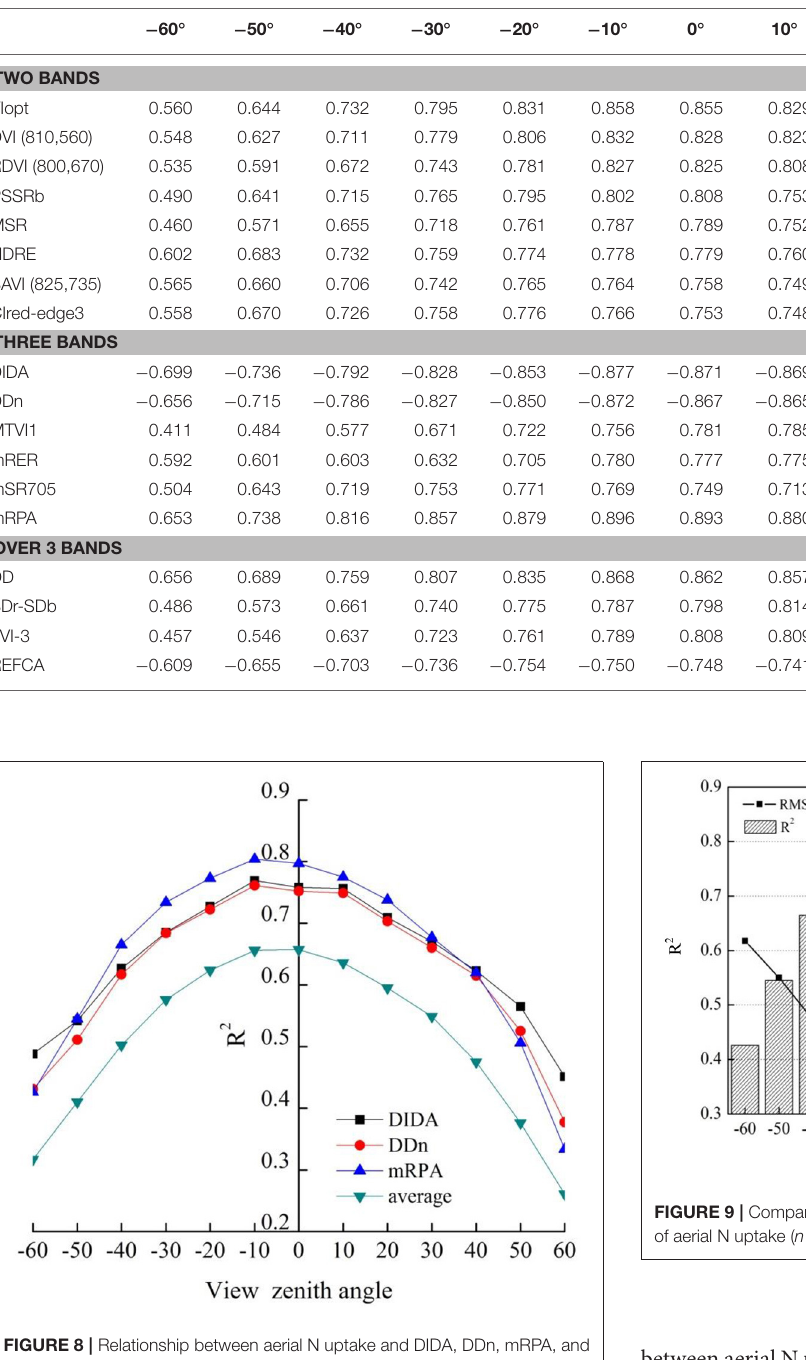
between aerial N uptake and mRPA. The R 2 increased from 0.734 (from − 30 ◦ to + 20 ◦ combination) to 0.782 (from − 20 ◦ to + 10 ◦ combination). Compared to the − 10 ◦ VZA having the highest R 2 value, mRPA in − 20 ◦ to + 10 ◦ combination only had a slightly decreased R 2 (2.7%) and an increased RMSE (5.2%). As a result, the novel mRPA model is the most forceful index for assessing aerial N uptake because of its insensitivity to VZAs of − 20 ◦ to + 10 ◦ , increasing the practicality of mRPA in actual production